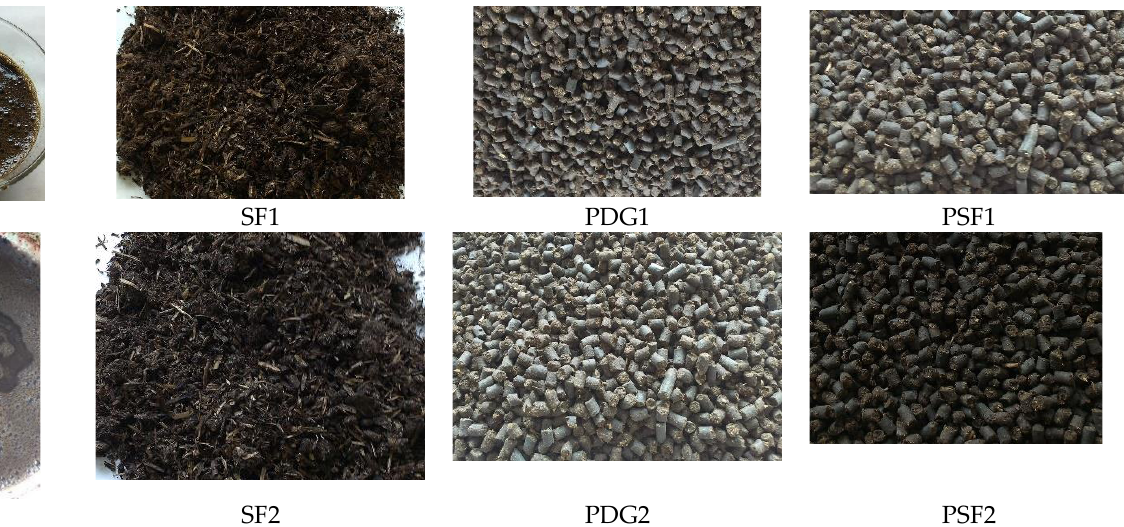
Figure 2. The digestate-based products (DGBPs): liquid fraction from DG1 and DG2 (LF1, LF2), solid fraction from DG1 and DG2 (SF1, SF2), pellets from DG1 and DG2 (PDG1, PDG2), and pellets from SF1 and SF2 (PSF1, PSF2).